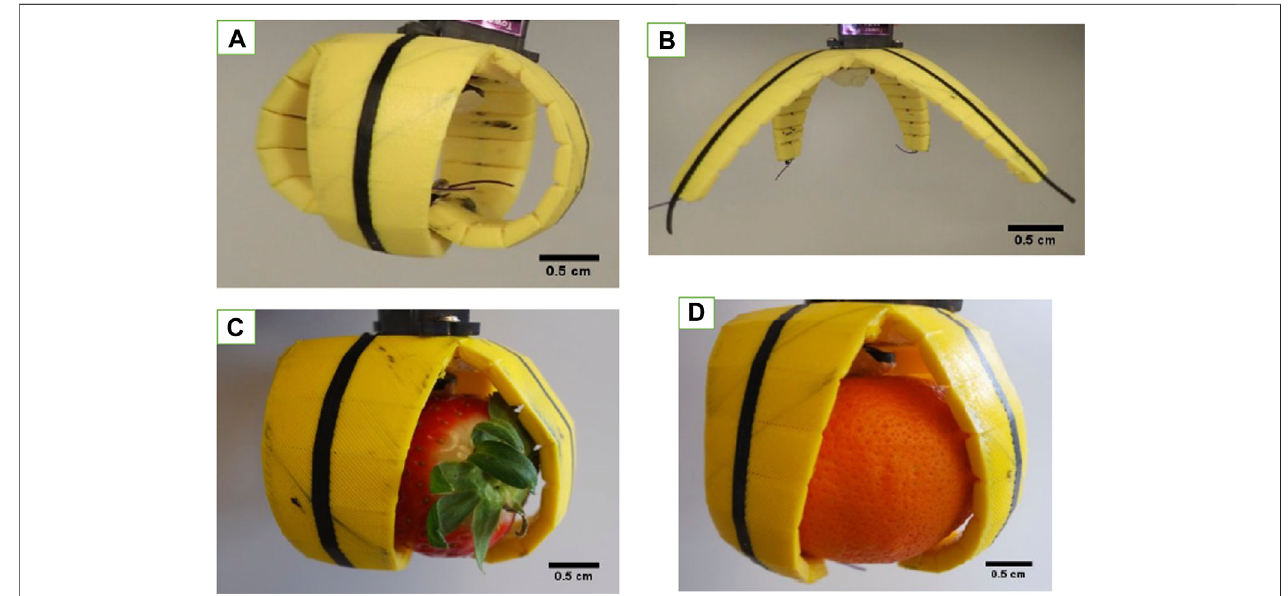
FIGURE 8 | Gripper with the integrated sensing elements in position (A) closed, (B) open, (C) gripping a small object, and (D) gripping a big object.